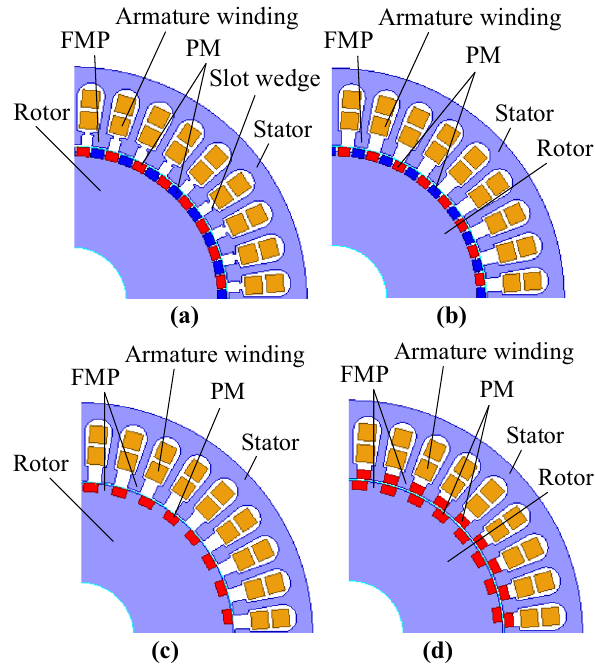
Figure 1. Structure of four kinds of magnetic field modulation PM machines. ( a ) FPGM, ( b ) SWL-FPGM, ( c ) CP-FPGM, and ( d )